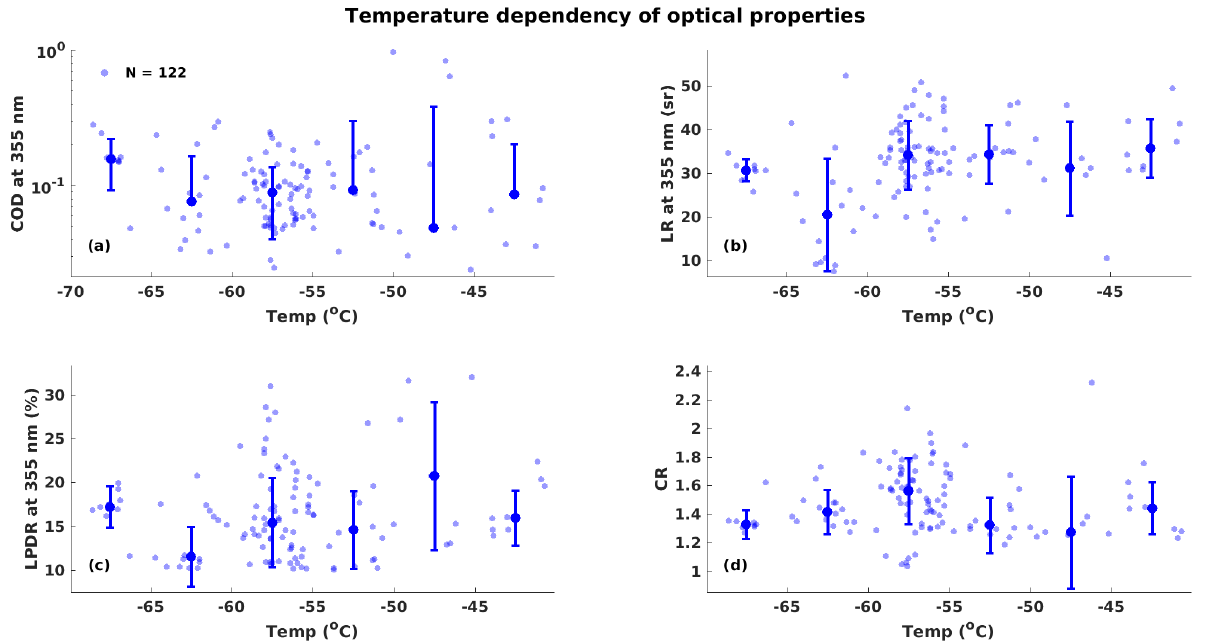
Figure 10. Cirrus layer optical properties versus median temperature. Overlaid are the median ± standard deviation optical properties per temperature (5 ◦ C classes). Only observations satisfying the 2 h temporal criterion are